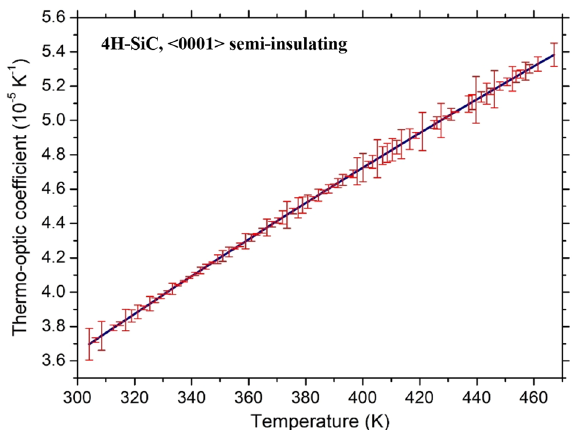
Figure 6. Polynomial fit and error bar of thermo-optic coefficient of 4H-SiC at the wavelength of 1.55